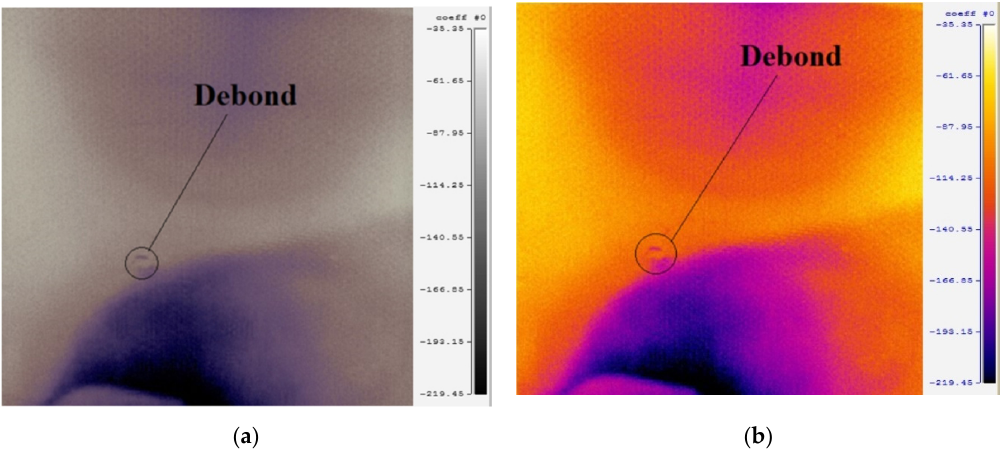
Figure 12. Debond localization maps corresponding to the selected polynomial coefficients for the recorded thermograms in (a) grey-scale and (b) colour-scale showing the actual debond location in the sample ACCS.